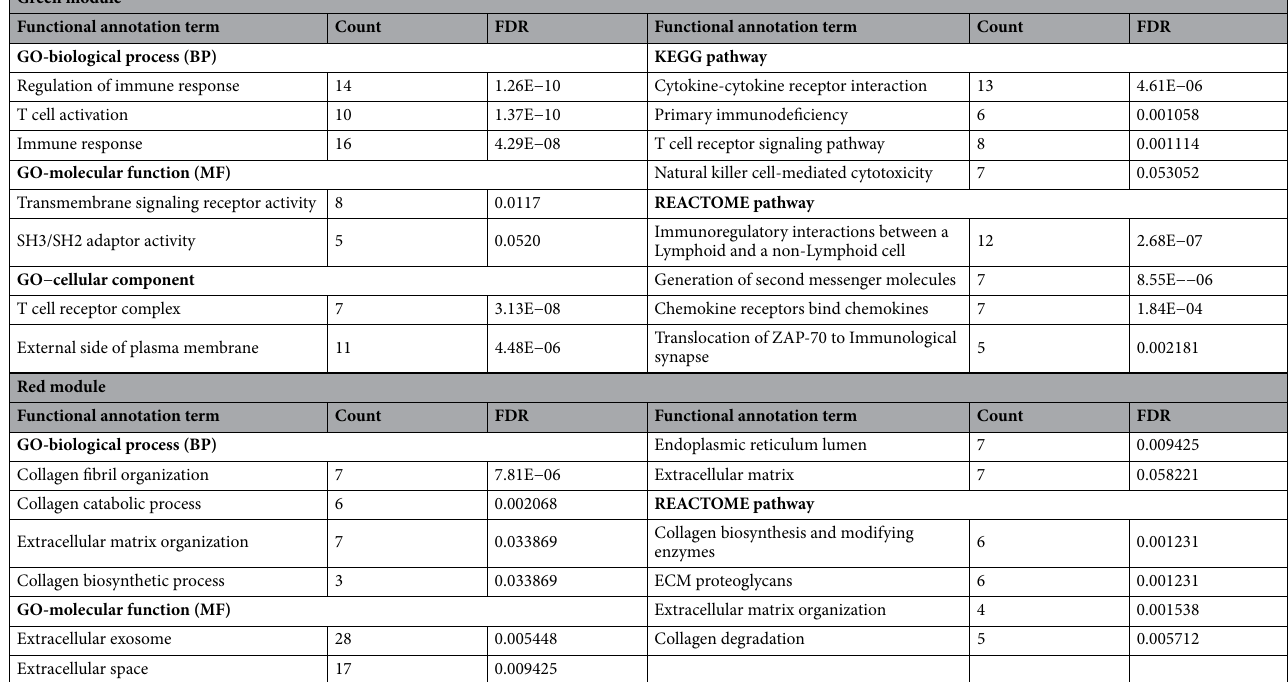
Table 3. Functional annotation terms in the green and red